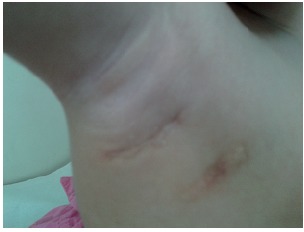
Lesão cicatrizada na região axilar e infra-axilar direita após o
tratamento.